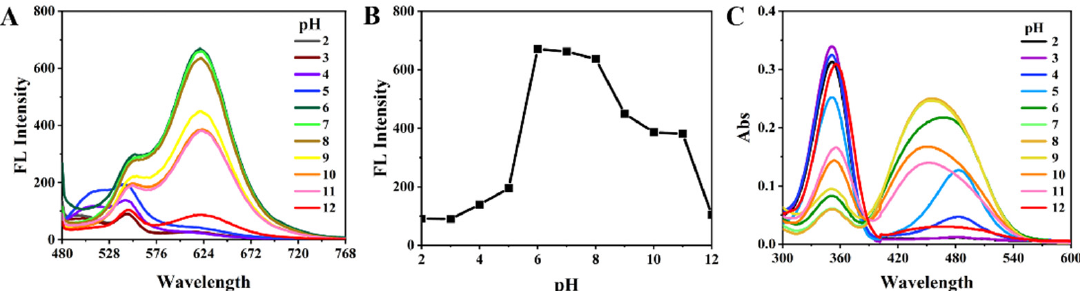
Figure 8. ( A ) Fluorescence spectra ( λ ex = 450 nm), ( B ) change in fluorescence intensity and ( C ) UV- vis spectra of BNEA in mixed solution containing mercury ions at different pH ([BNEA] = 10 μ M) .